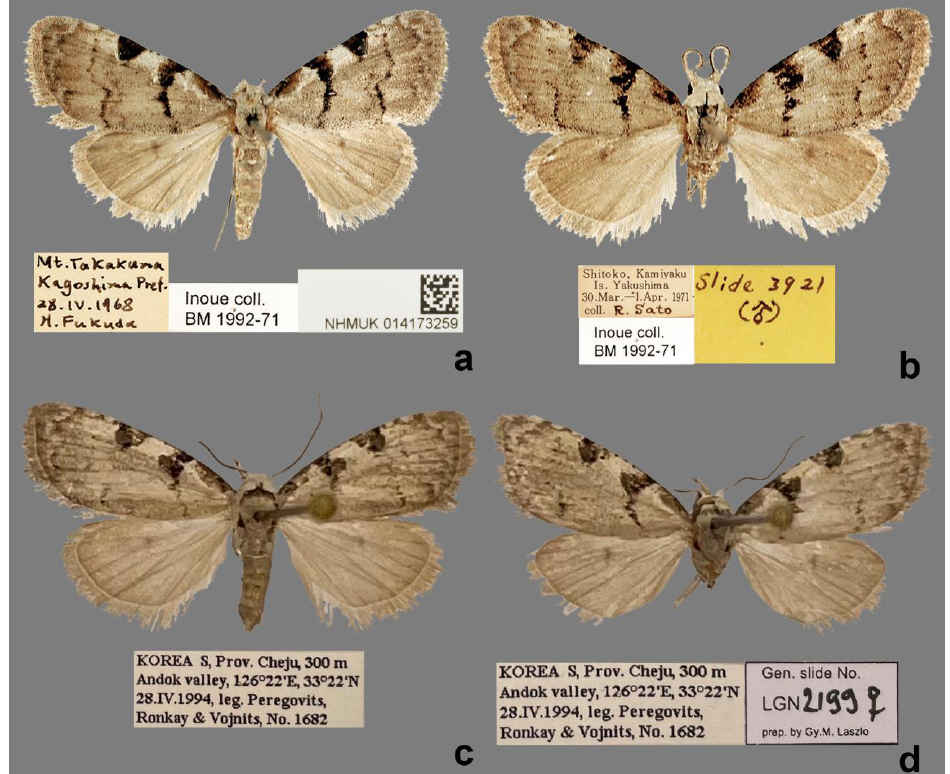
Figure 3. Adult and label illustrations of Nola galliphaga sp. nov. : ( a ) N. galliphaga sp. nov. , female, holotype (NHMUK, unique id. NHMUK 014173259, gen. slide No. NHMUK 010317817); ( b ) Ditto , male, paratype (NHMUK, Inoue genitalia slide 3921); ( c ) Ditto , female, paratype (HNHM); ( d ) Ditto , female, paratype (HNHM, gen. slide No. LGN 2199).